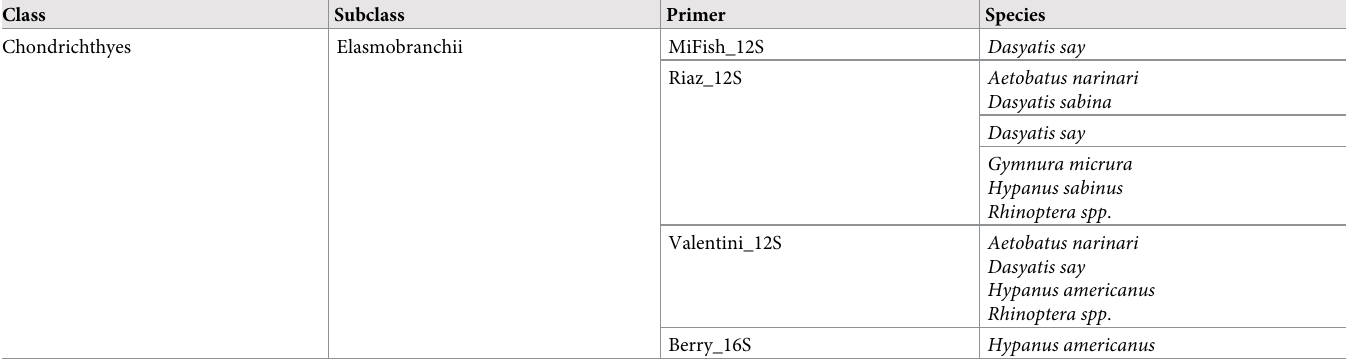
Table 4. Species of cartilaginous fishes detected with each of the four metabarcoding primer sets tested in this study. Class